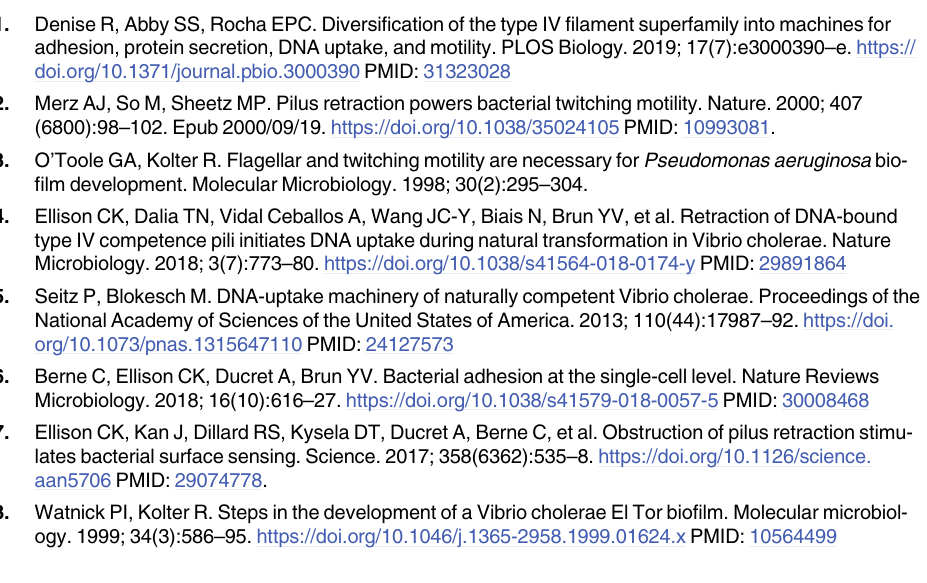
S8 Fig. The MshA V27F and MshA R32L suppressor alleles promotes assembly of wild-type MshA. Representative images of cells from Δ pilT strains expressing the indicated mshA allele at the native locus (native mshA allele) and ectopic locus (P -riboswitch- mshA allele). Cells tac were either grown with (”+”) or without (”-”) 100 μ M IPTG + 1.5 mM theophylline to induce the ectopic P -riboswitch- mshA allele in the strain as indicated. Only the alleles containing tac the T70C mutation can be labeled with AF488-mal and are denoted in green text in the table below the images. Scale bar = 2 μ m. S1 Table. Strains used in this study. S2 Table. Primers used in this